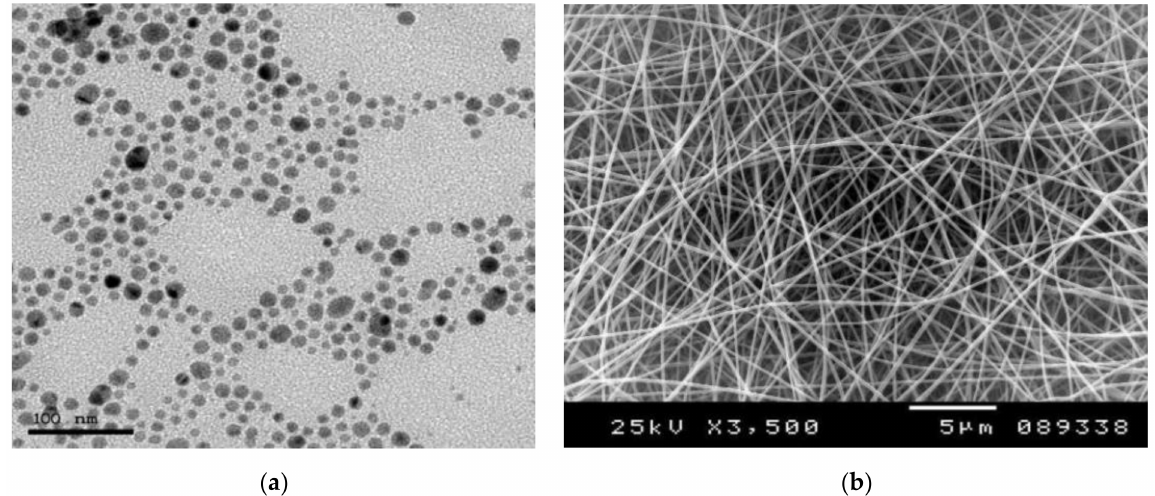
Figure 2. ( a ) TEM image of AgNPs spheres (<20 nm) as previously reported by El-khatib et al. [19], and ( b ) SEM image of electrospun nanocomposite